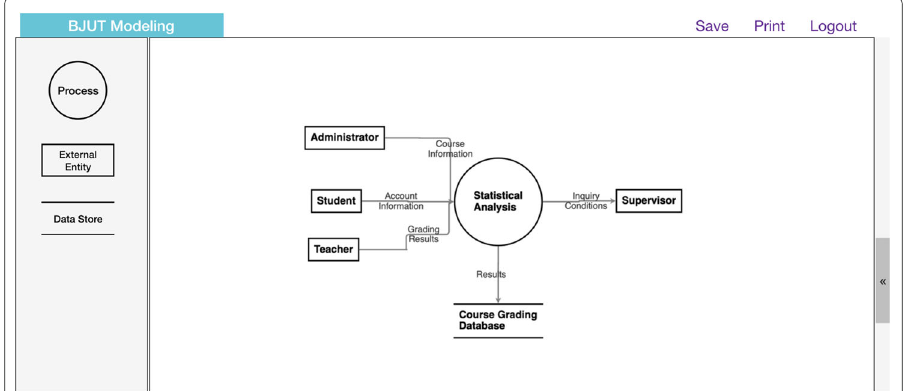
Fig. 2 Online modeling platform, named